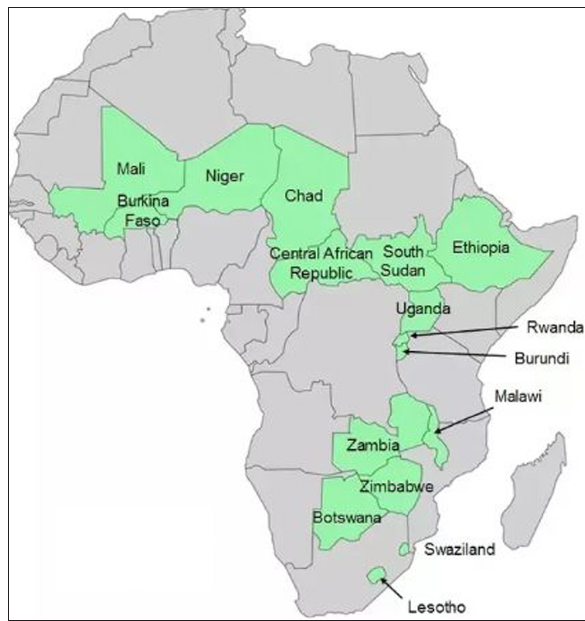
Figure 1: Landlocked African countries. The Republic of South Sudan was not included in the analysis as data were not available.